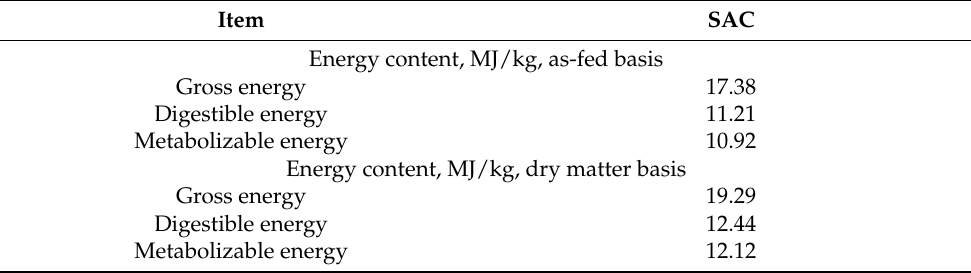
Table 5. Energy content (MJ/kg) in Selenium Auricularia cornea culture (Exp. 1) a . Item